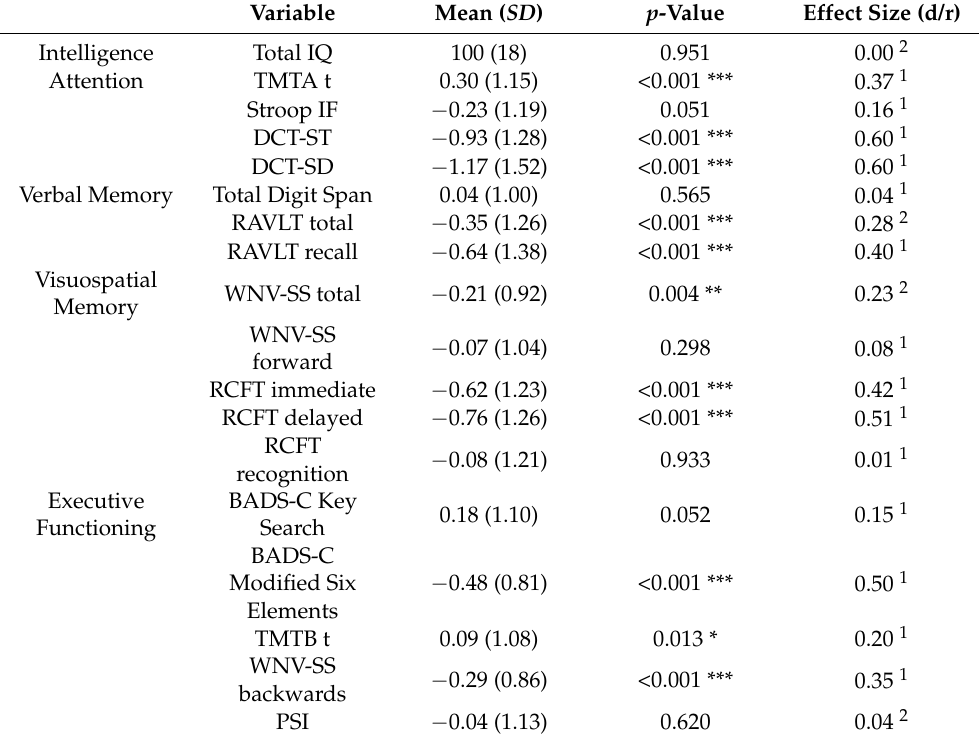
Table 3. Norm data comparison neuropsychological